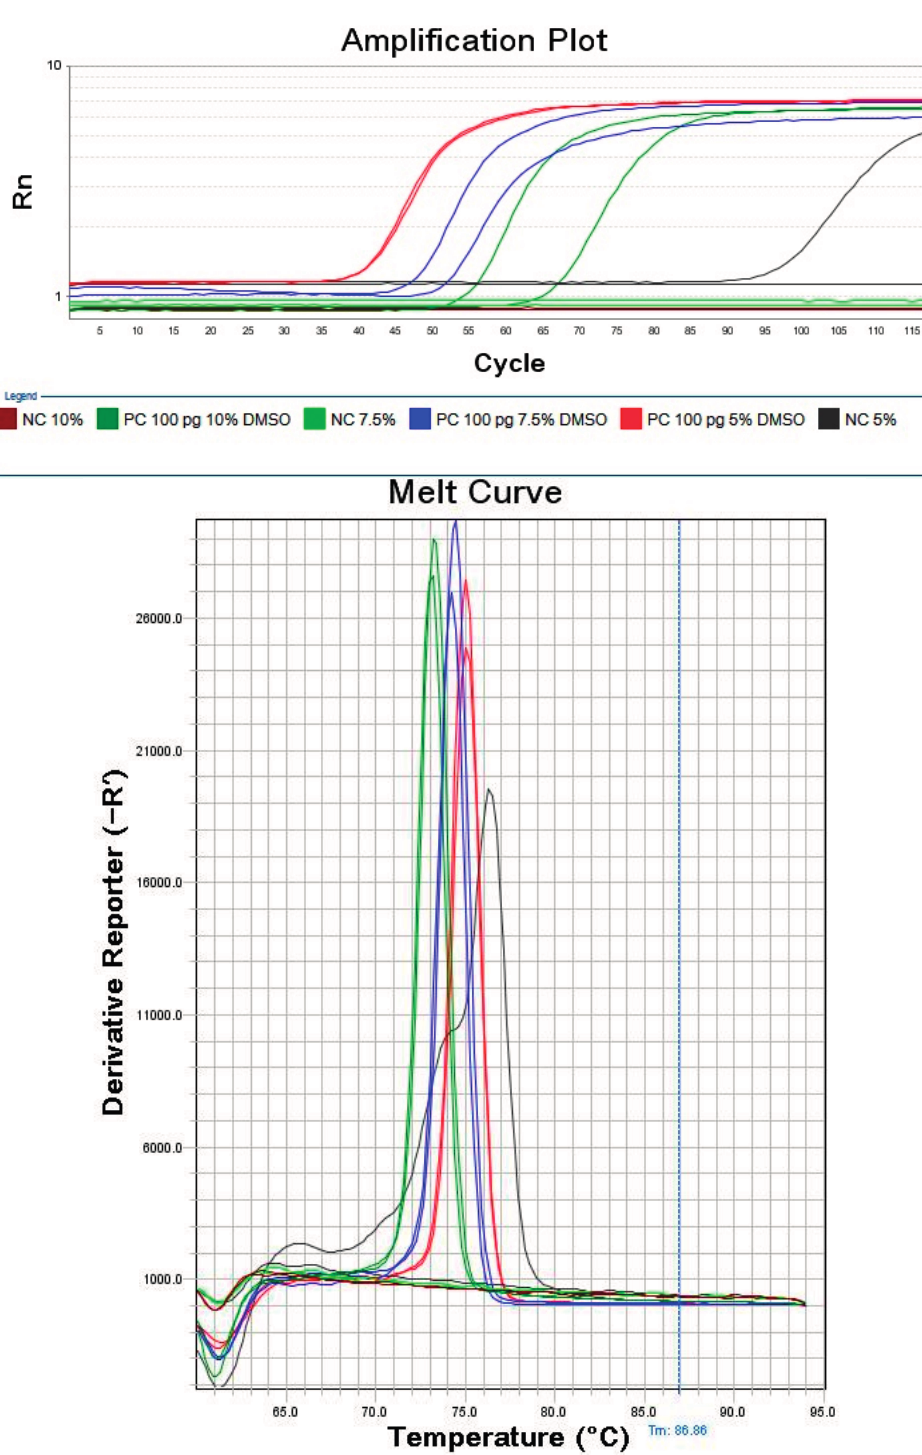
Figure 1. Amplification plot and melt curve of LAMP with varying concentrations of DMSO. The plot type was Rn vs. Cycle, and the graph type was log with 1× SYBR Green I added and 1× ROX as Reference Dye; the plot of Melt Curve was Derivative